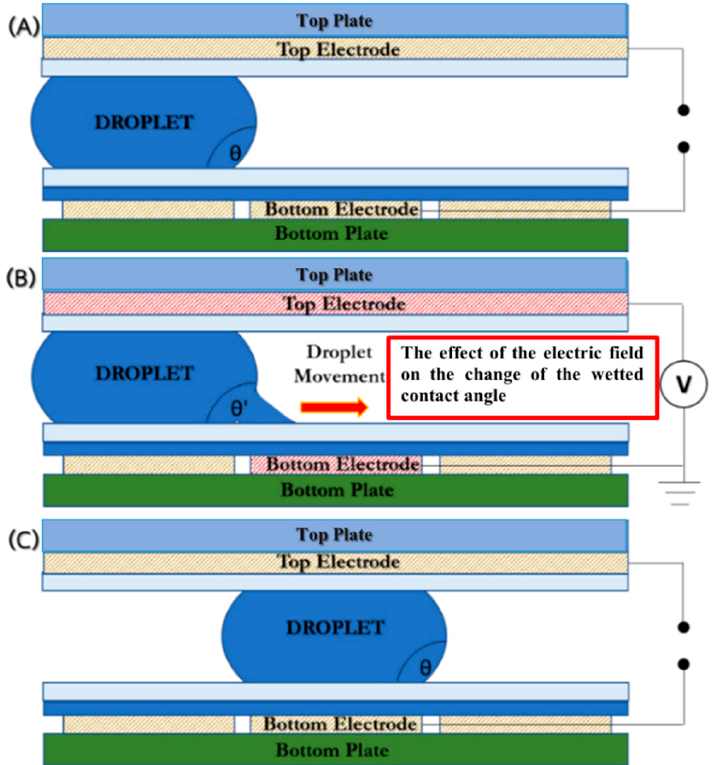
Figure 2. Effect of applied electrical potential on a droplet in a closed-type EWOD. ( A ) the droplet initial contact angle, ( B ) the change of contact angle due to the applied electrical field causing the droplet to move to the adjacent electrode, and ( C ) the droplet situated at the new position.